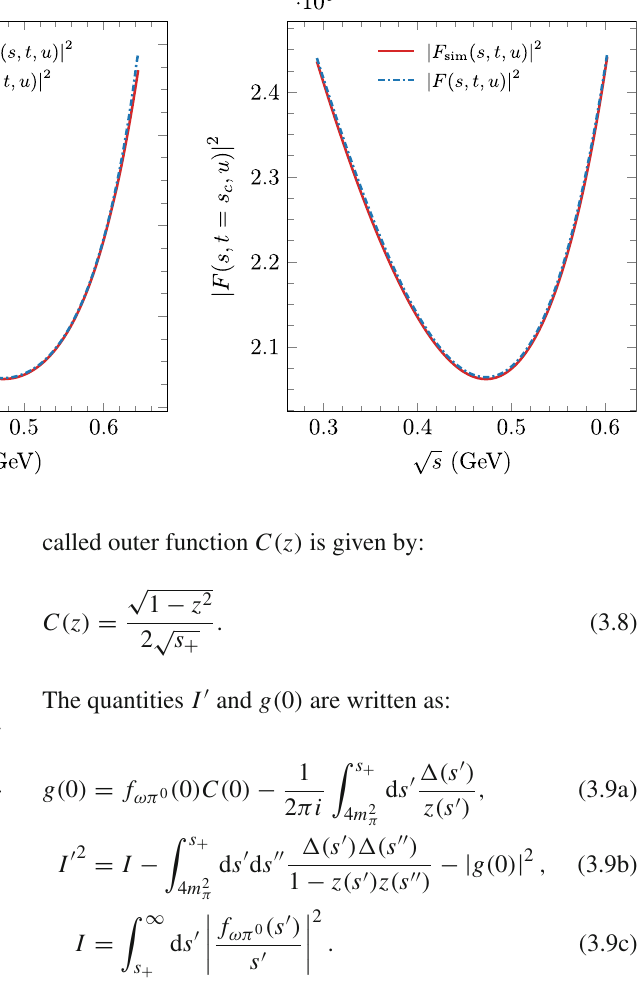
Fig. 10 Modulus squared of the amplitudes in our full model ( F ( s , t , u ) , dashed blue lines) and in the simplified model ( F sim ( s , t , u ) , Eqs. (3.4), solid red lines). The left (right) plot shows the functions along the t = u ( t = s c ) lines of the Mandelstam plane. The ratio is shown in the physical decay range of s for each of the cases